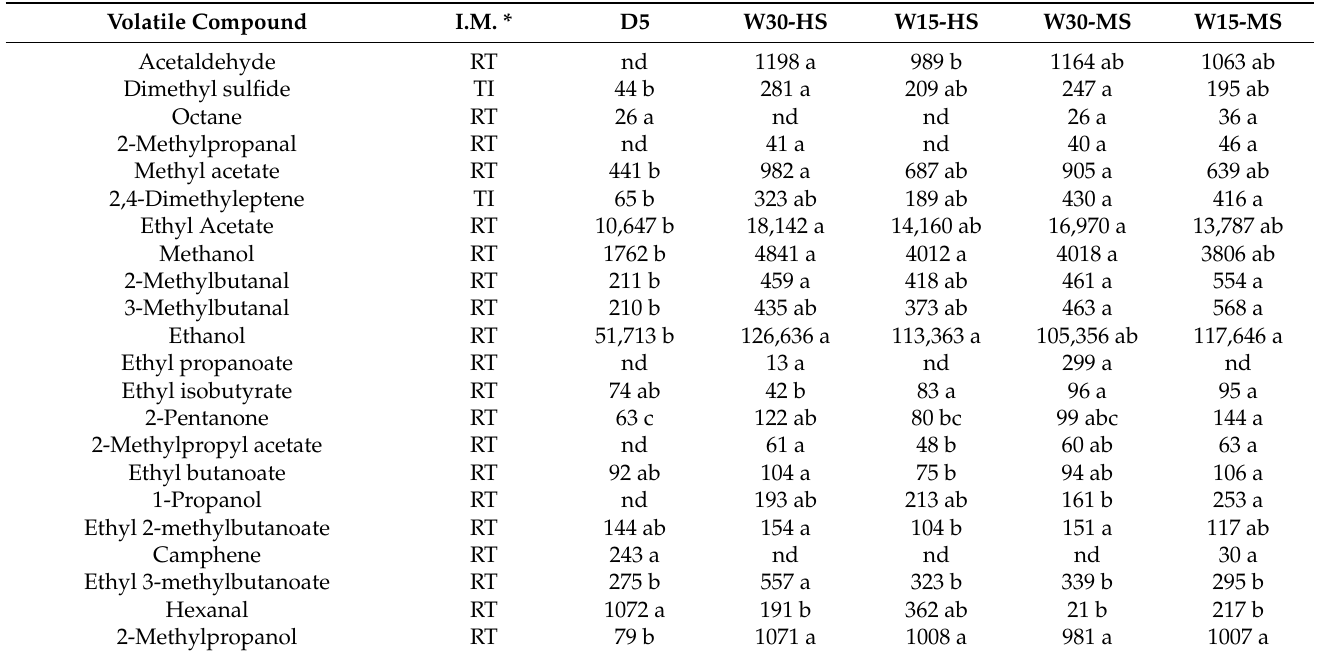
Table 4. Volatile compounds in the brine of ‘Itrana’ table olives processed by using different salt concentrations and fermentation times. Data were taken after 165 days from the beginning of the process, except for D5 (olives five days following the beginning of the treatment). Samples are as follows: 30 days in water and then salting with 8% NaCl brine (W30-HS); 15 days in water and then salting with 8% NaCl brine (W15-HS); 30 days in water and then salting with 6% NaCl brine (W30-MS); 15 days in water and then salting with 6% NaCl brine (W15-MS). Within each row, different letters indicate significant differences between treatments according to Tukey’s test ( p ≤ 0.05). Values are expressed as µ g internal standard per L of brine ( n =